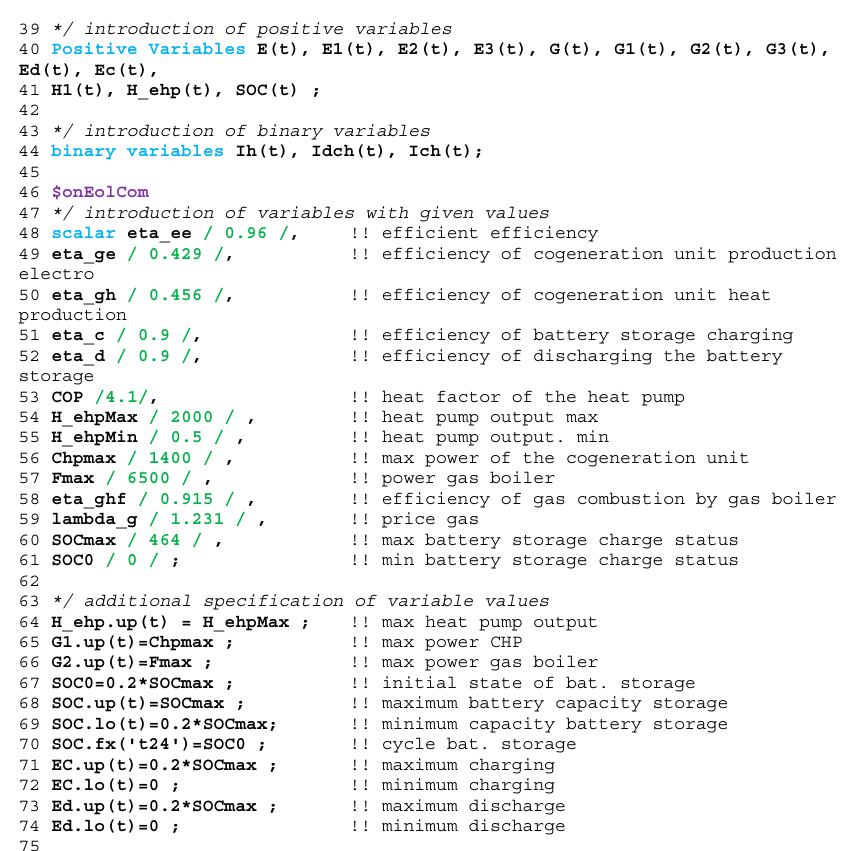
Figure 23. Introduction of variables.